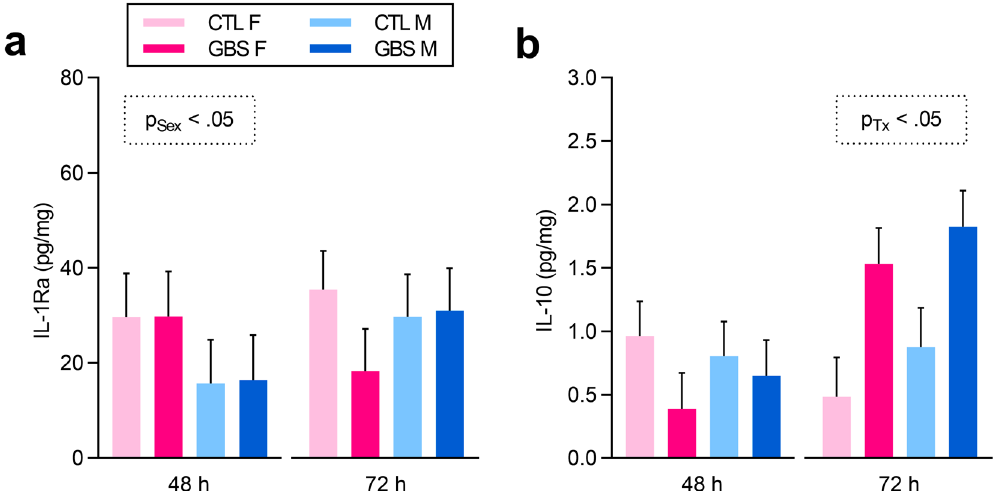
Figure 6. GBS-infected placentas displayed a sexually dichotomous anti-inflammatory profile. ( a , b ) Mean protein levels of IL-1Ra ( a ) and IL-10 ( b ) detected in placentas at 48 and 72 h post-injection by ELISA. Analyses were done by linear mixed model and significant results are shown in the dashed box. Number (n) of placentas: n = 3 [48 h] and n = 6 [72 h] per sex in the GBS group, and n = 5 [48 h] and n = 5 [72 h] per sex in the CTL group. One male and one female placentas were used per litter. Abbreviations: CTL, Control; F, Female; GBS, Group B Streptococcus ; h, hour; IL, Interleukin; IL-1Ra, Interleukin-1 Receptor antagonist; M, Male; Tx,